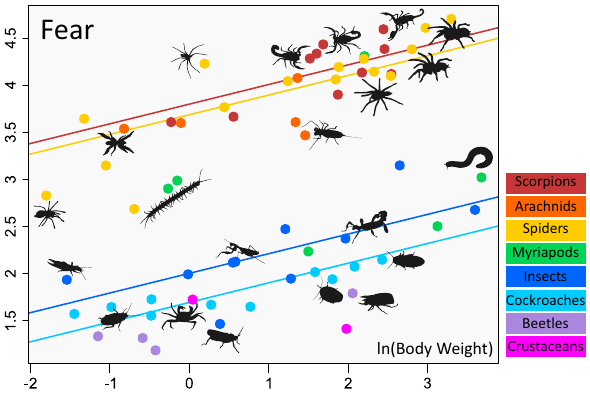
Figure 2. Relationship between body weight and observed mean fear scores. Each dot represents one stimulus (species), regression lines for the four focal groups are shown. The slope of the lines (0.208) does not differ between the